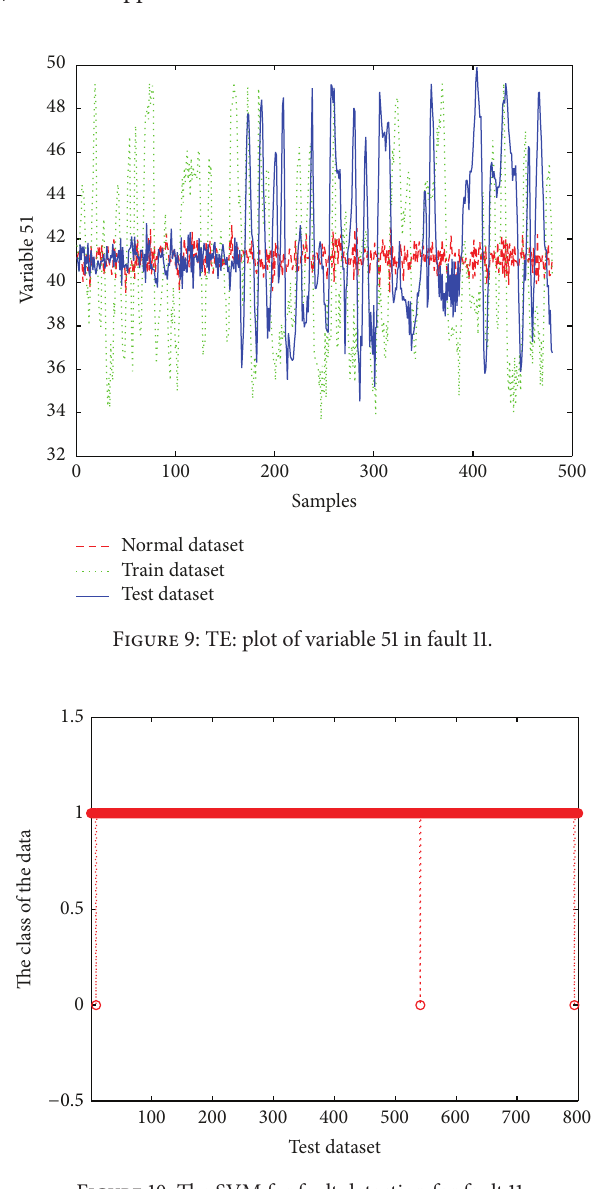
Figure 10: The SVM for fault detection for fault 11.